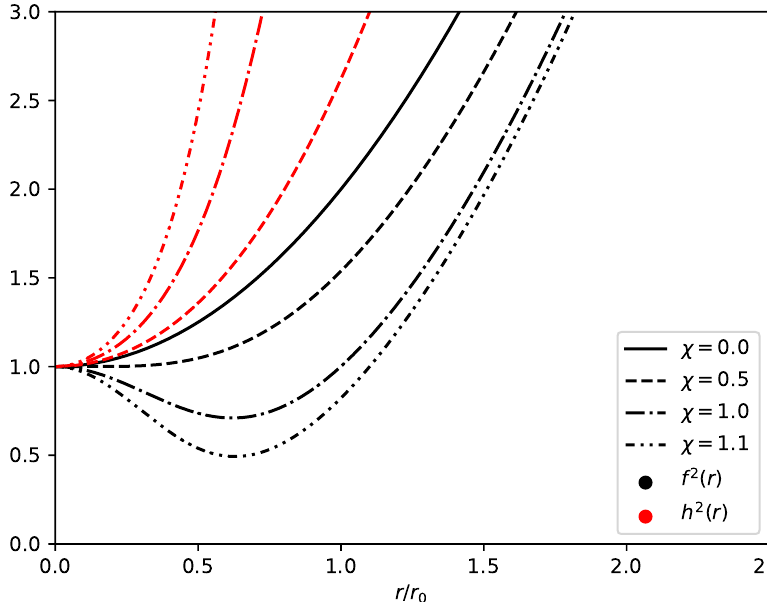
Figure 7 . Metric components of the non-singular self-gravitating Abrikosov vortex of vorticity N = 1 in asymptotically AdS 3 space-time of radius ‘ = 1 for increasing values of the “strength of gravity” χ = 16 πGv 2